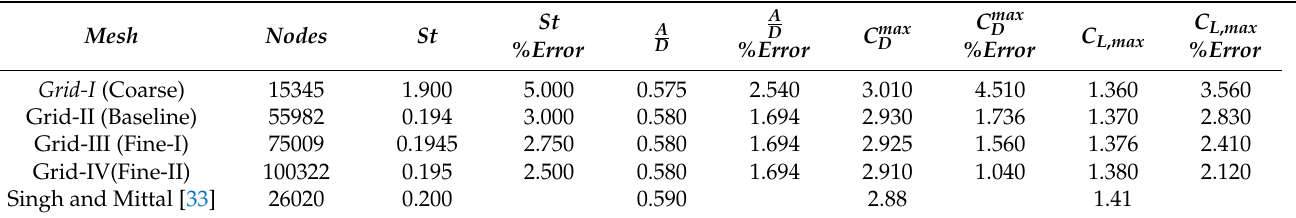
Table 1. Vortex-induced vibration parameters for Ur = 4.94 and Re = 100. Key parameters such as maximum amplitude, average drag coefficient, maximum drag coefficient, and lift coefficient are summarized in the table